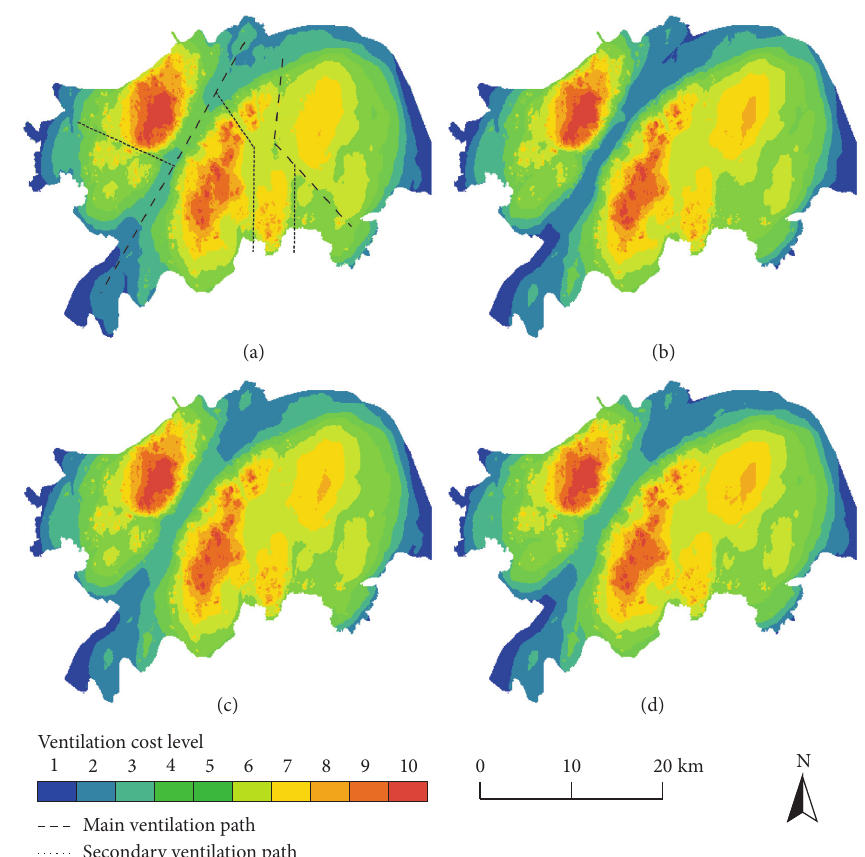
Figure 7: Spatial distribution of ventilation during different seasons. (a) Spring. (b) Summer. (c) Autumn. (d) Winter.